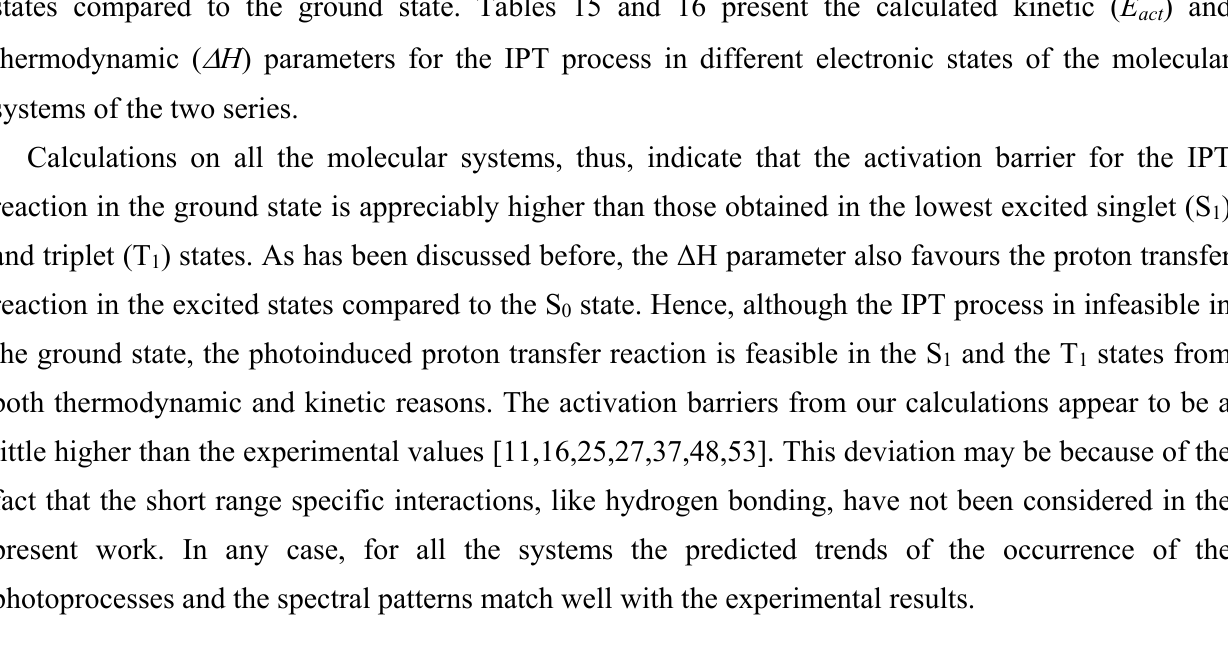
Table 15. Calculated activation energies ( E intramolecular proton transfer reaction of HBO, HBI and HBT in S Medium /